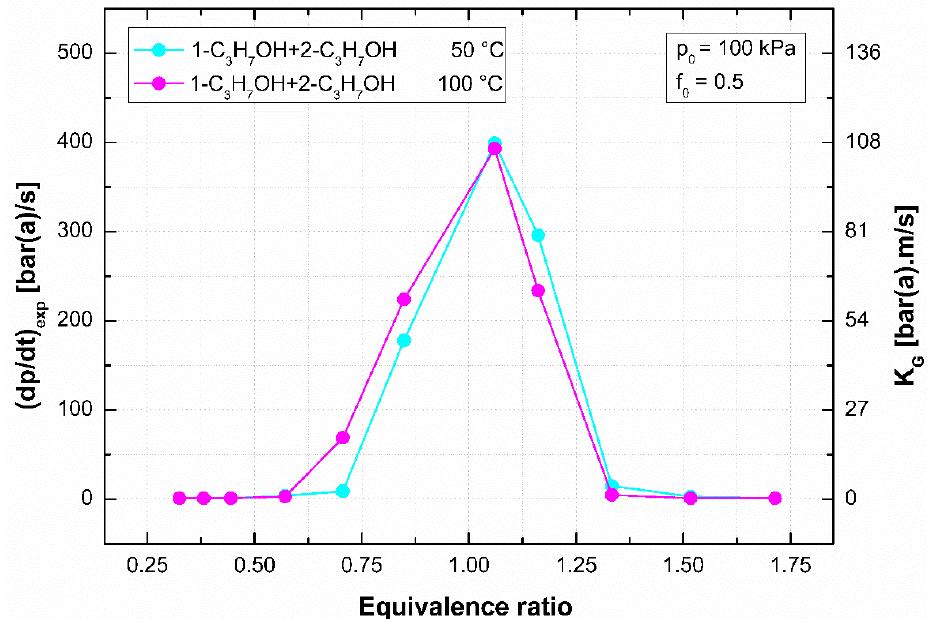
Figure 9. (dp/dt) ex versus Φ = 0.3–1.7 for 1-propanol/2-propanol–air mixtures (f 0 = 0.5) at various initial Figure 9. (dp / dt) ex versus Φ = 0.3–1.7 for 1-propanol / 2-propanol–air mixtures (f 0 = 0.5) at various temperatures and mixture compositions, p 0 = 100 kPa. initial temperatures and mixture compositions, p 0 = 100